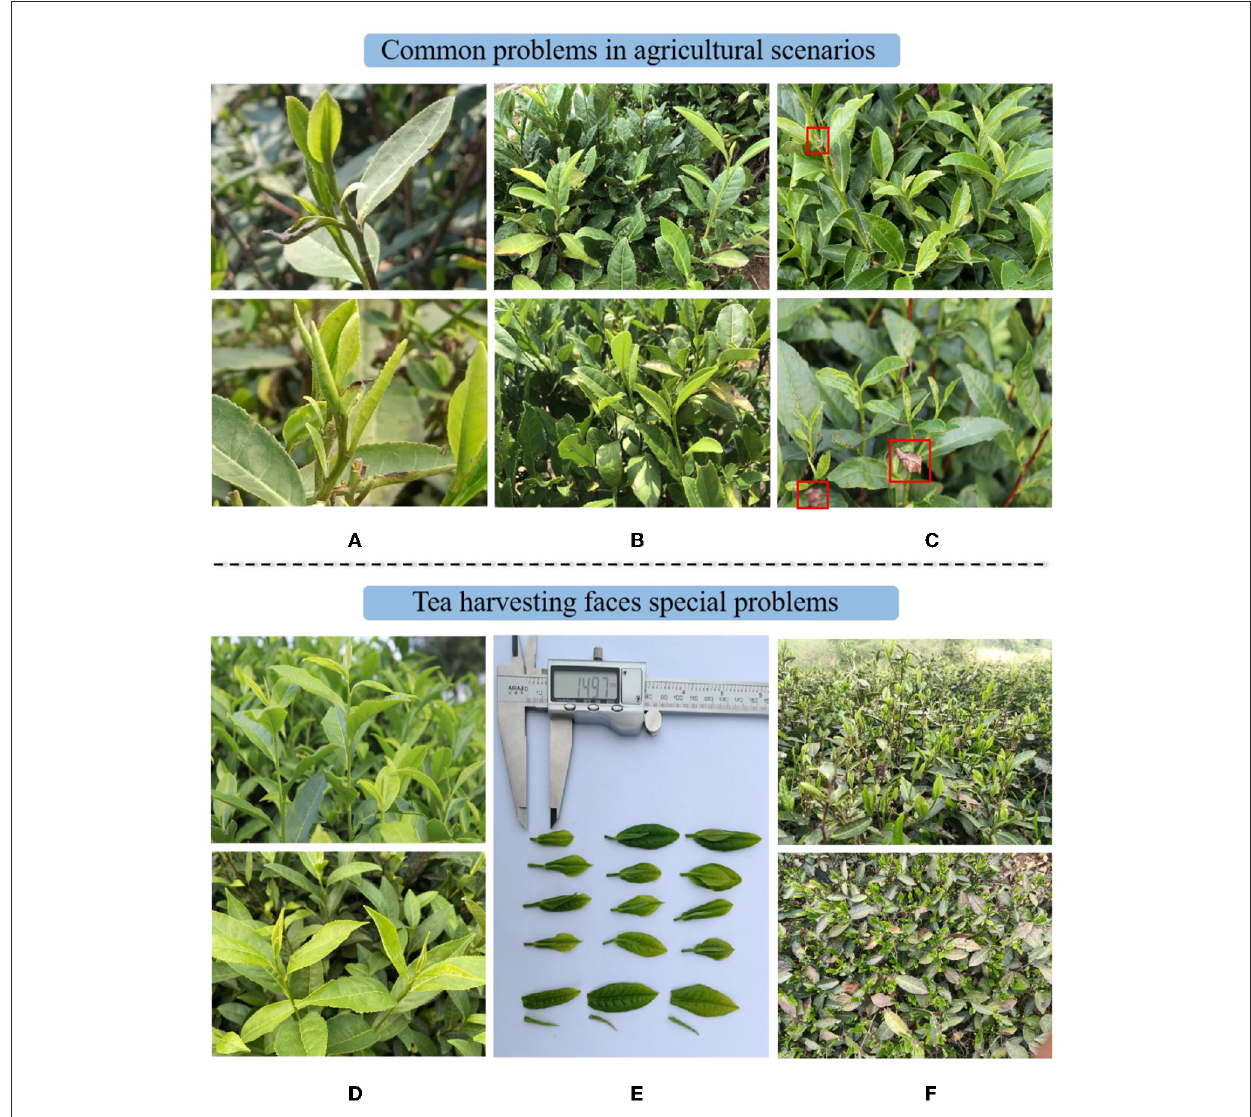
FIGURE4 Difficulties of vision-based tea harvesting machines: (A) Obscured targets; (B) Unstable light; (C) Complex environment (e.g., presence of pests, dead leaves, etc.); (D) Small differences in target and background characteristics; (E) Small size and easy to break, reproduced from Li Y. et al. (2021); (F) High target growth